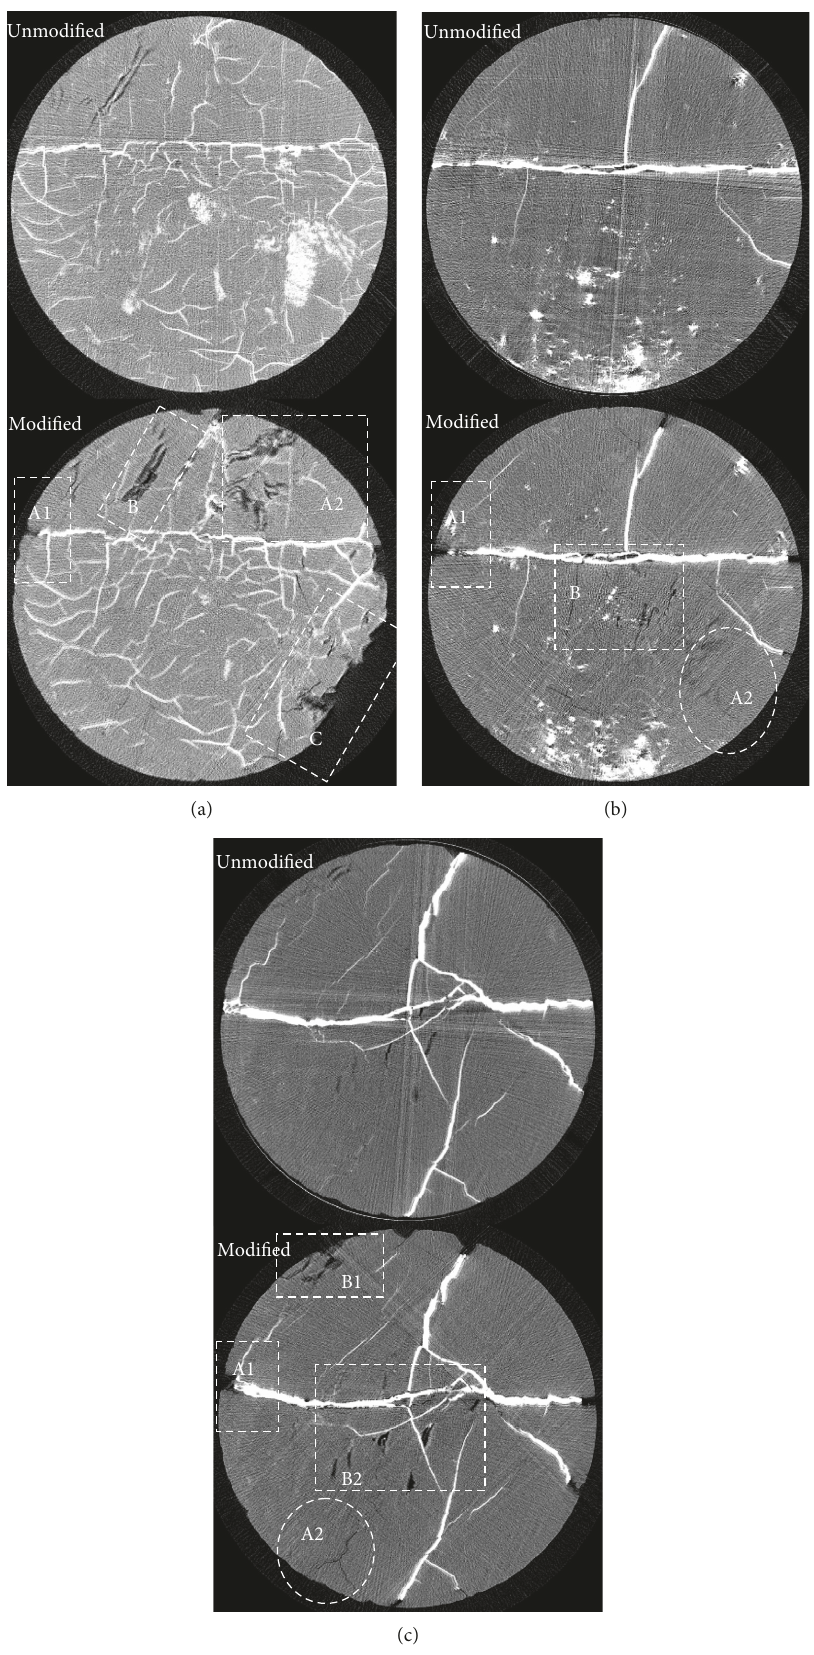
Figure 4: CTimage of the structure of coal in the anodic area after modification. (a) Top section, (b) middle section, and (c) bottom